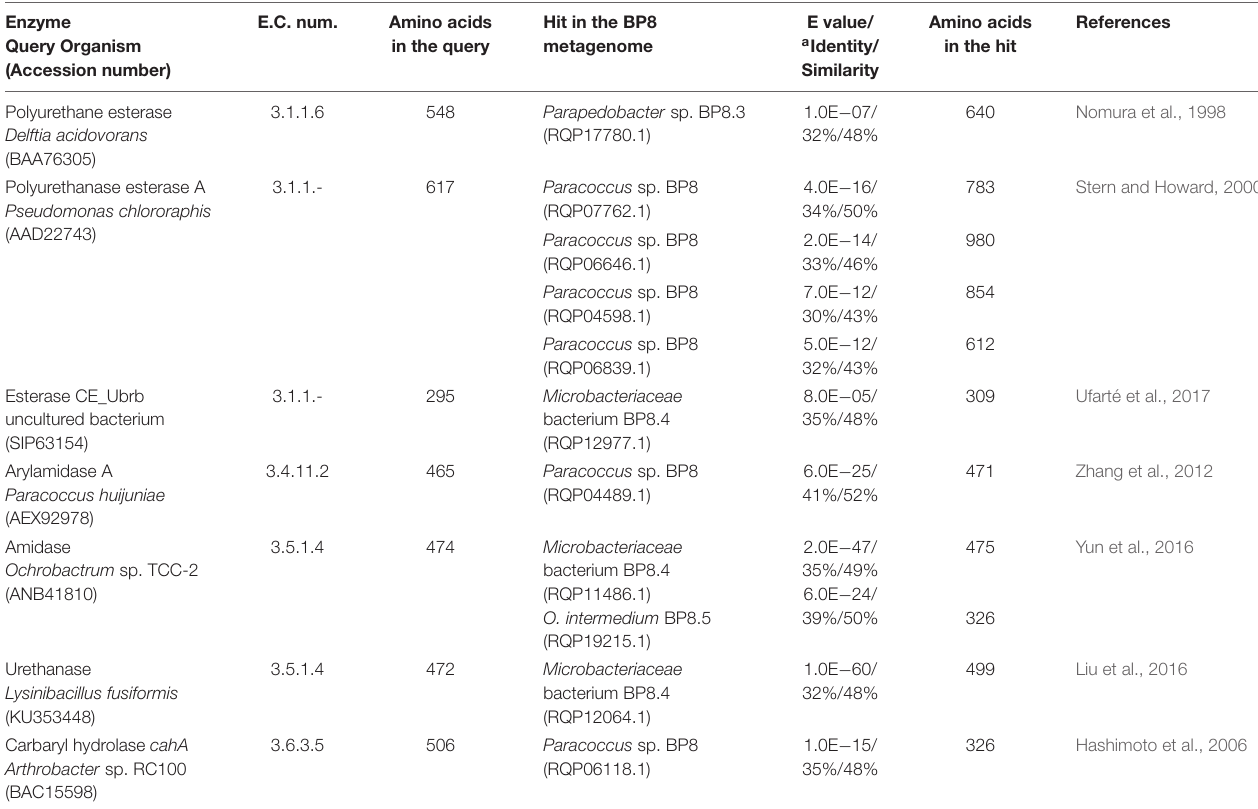
TABLE 4 | Esterases and carbamate hydrolyzing enzymes encoded in the BP8 metagenome. Enzyme Query